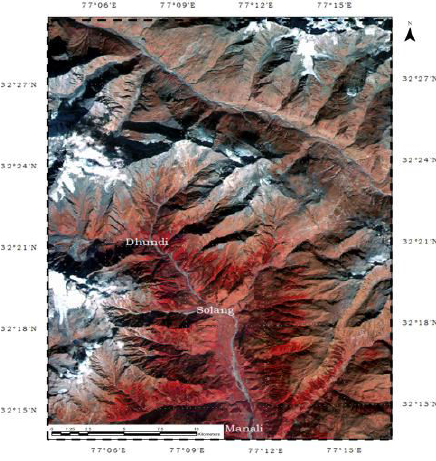
Figure 1: Multispectral Image showing the Study Area ADS80 DEM